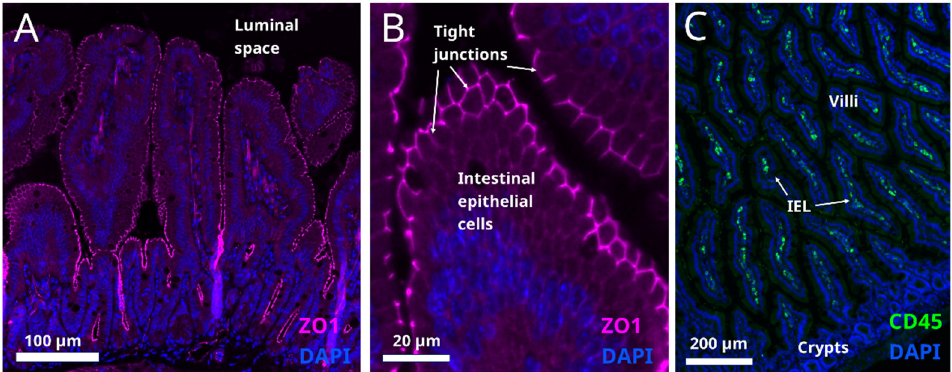
Figure 4. ( A , B ) Tight junctions are situated on the apical surface of the intestinal epithelial layer (cell nuclei are labelled with DAPI, blue) in mouse small intestine section. They are identified by immunostaining for ZO1, a tight junction marker, magenta labelling). Presence of microbial pathogens in the luminal space impairs the integrity of tight junctions (not shown). ( C ) Intraepithelial lymphocytes in mouse small intestine identified by immunostaining for their marker CD45 (green). Nuclear marker DAPI is shown in blue. In obesity, IELs infiltrate the intestinal epithelium and the cytokines released by IELs damage the cell connections in the epithelial layer (not shown).